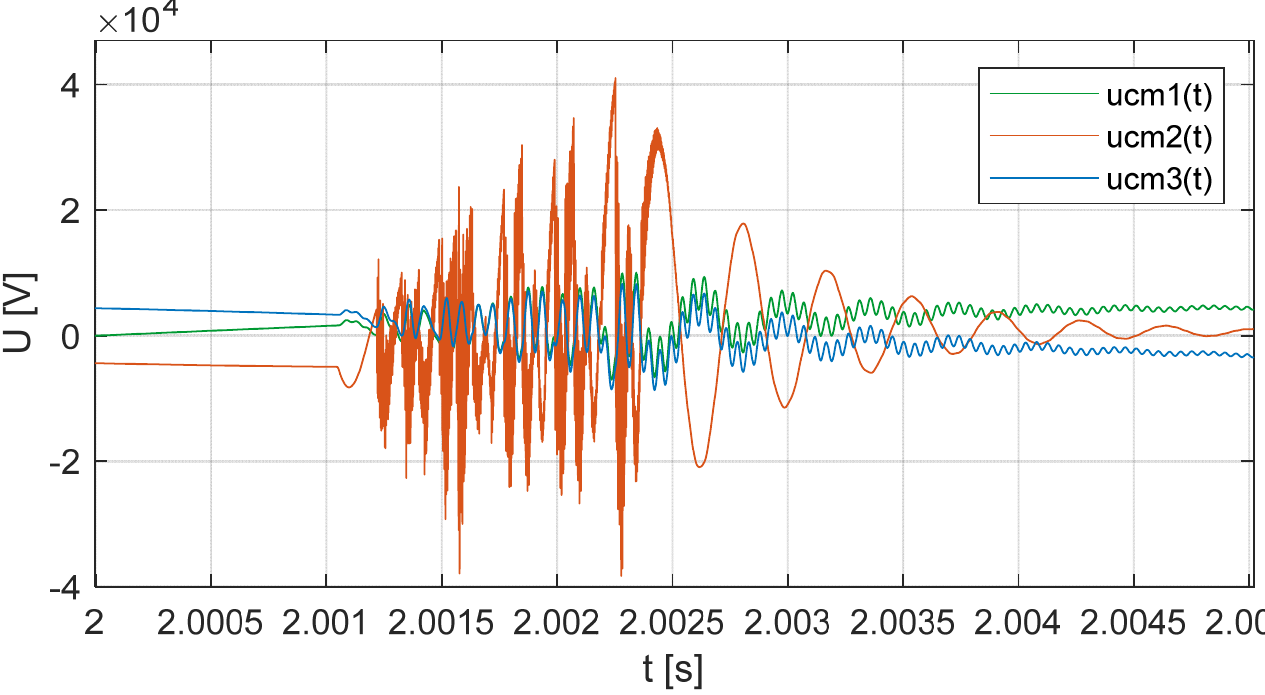
(𝑡) (EMTP algorithm). Source: own calculations. (cid:3004) (cid:3265)